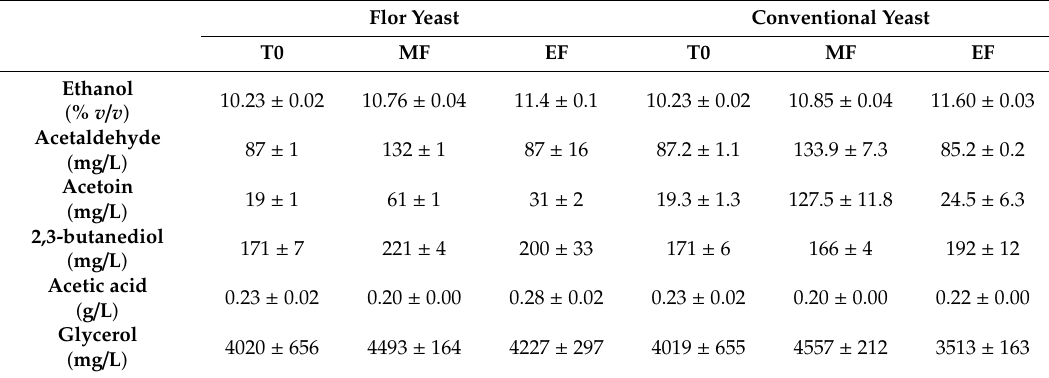
Table 1. Composition of the base wine (T0) and the Spanish sparkling wine at the middle of the second fermentation (MF) and at the end of the second fermentation (EF) in flor yeast and conventional yeast strains. Data provided by Mart í nez-Garc í a et al. (2017) and (2020) [17,25]. Flor Yeast Conventional